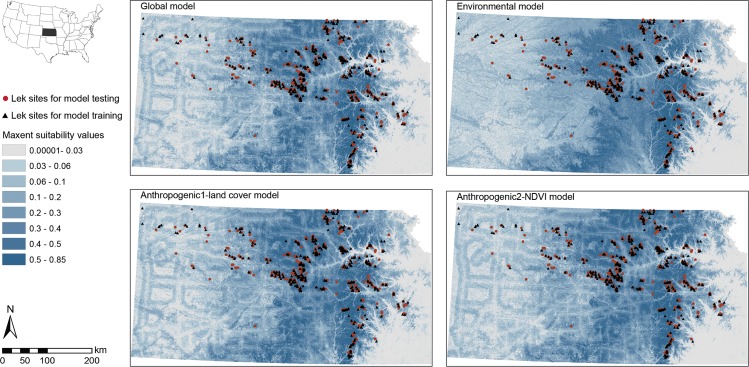
Maps of suitability for Greater Prairie-Chicken in Kansas, estimated using four separate models.Models generated using locations of 870 unique lek sites in Kansas from 2003–2011 (training dataset represented by black triangles and testing dataset by red dots). Areas most suitable are represented by the darkest shade of blue and the lowest by the lightest shade. The global model incorporated elevation, slope, land cover, normalized difference vegetation index (NDVI), density of transmission lines, density of roads, and density of oil and gas wells; the environmental model incorporated elevation, slope, land cover, and NDVI; the anthropogenic1-land cover model included all variables except NDVI and anthropogenic2-NDVI model incorporated all variables except land cover.